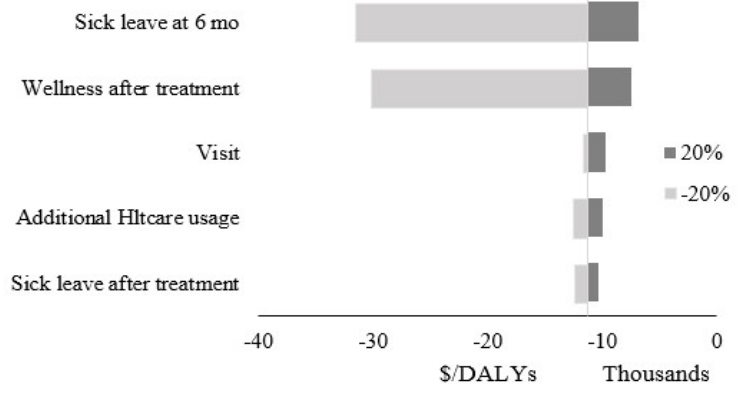
Figure 2. Tornado Figure 2. Tornado graph.